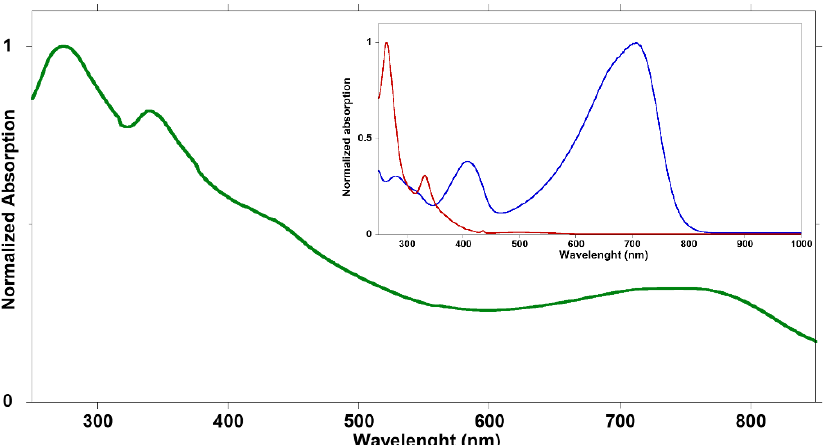
Figure 2. Normalized absorption spectrum of BCP15 bWPNPs dispersion after dilution with water 1:100 (green line); in the inset normalized spectra of BCP15 (blue line) and PCBM (red line) dissolved in chloroform.